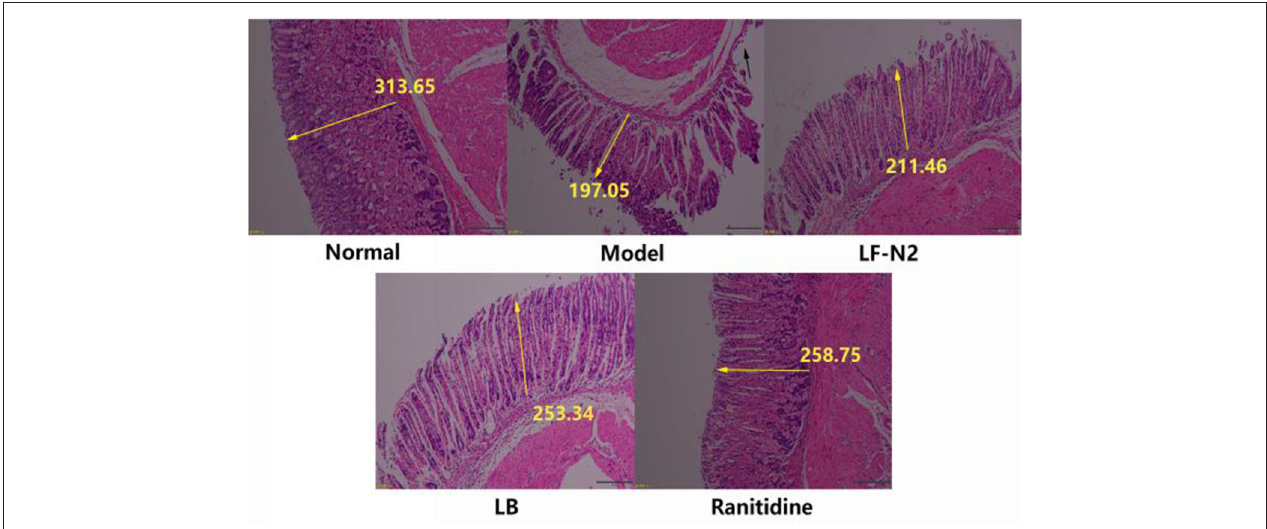
FIGURE 2 | Levels of antioxidant factors in serum and gastric tissue. LF-N2, Lactobacillus fermentum TKSN02 (1 × 10 9 CFU//kg); LB, Lactobacillus bulgaricus (1 × 10 9 CFU/kg); ranitidine (200 µ g/g). The yellow arrow shows the relative length.